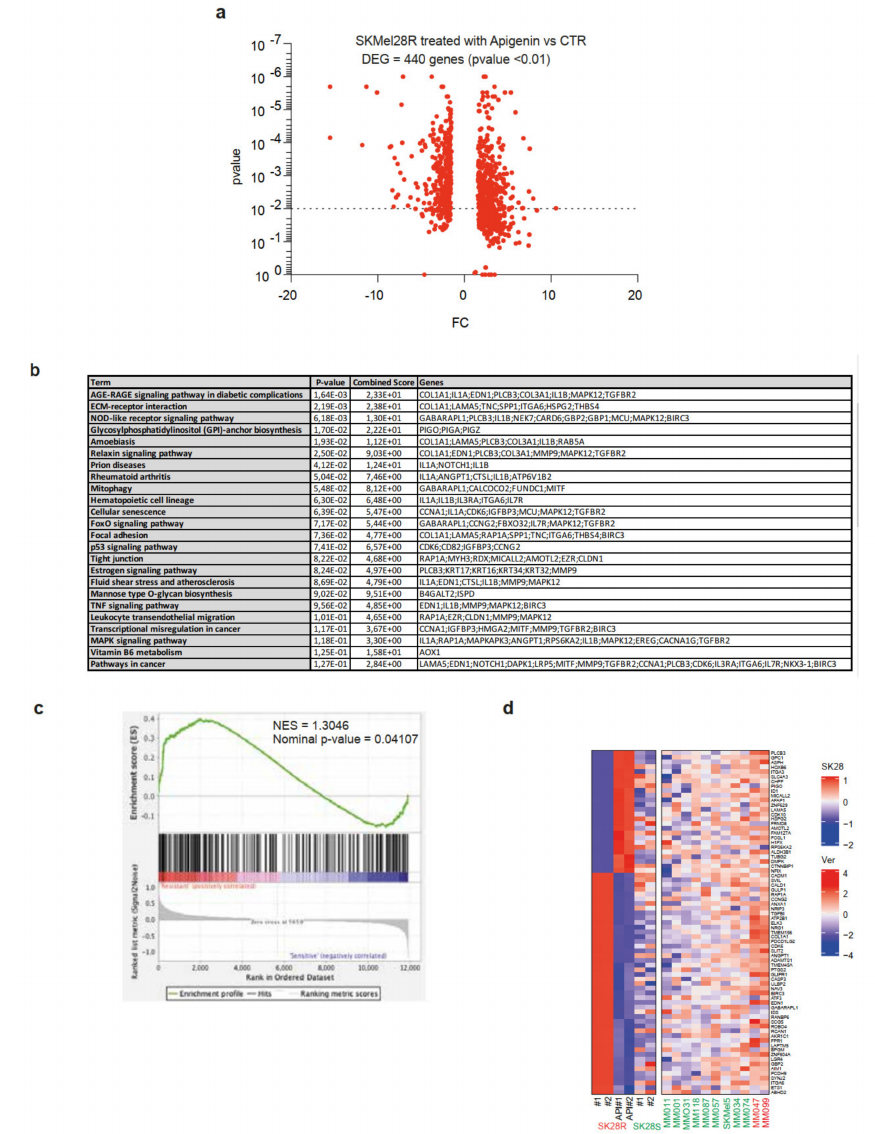
Figure 5. Apigenin treatment decreases the expression of genes associated with resistance in melanoma. ( a ) Volcano plot combining the magnitude of the fold change (ratio of expression between resistant and sensitive SK28 cell lines) and the p -values for di ff erentially expressed genes between SKMel28R cells